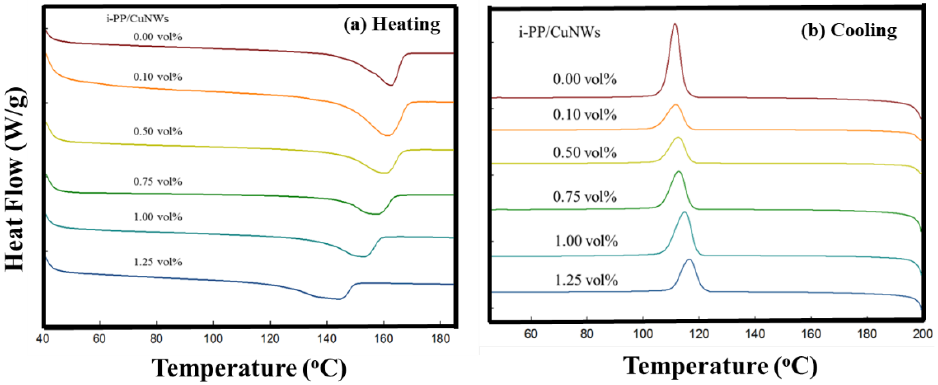
Figure 7. The DSC spectra of solution-cast i-PP/CuNWs composites.